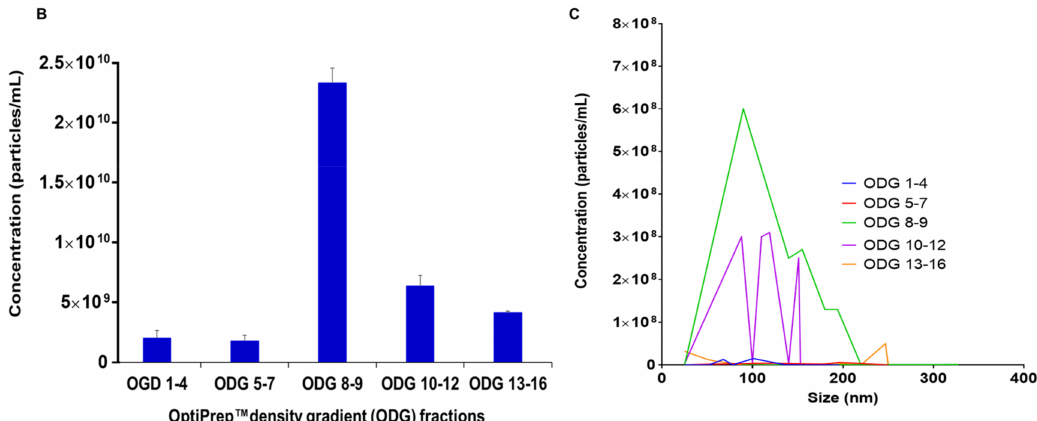
Figure 1. Characterization of EVs derived from concentrated conditioned medium (CCM) to demonstrate the abundance of EVs in the gradient fractions 8 and 9 after OptiPrepTM density gradient (ODG) ultracentrifugation. Pooled gradient fractions (ODG 1–4, 5–7, 8–9, 10–12, 13–16) were analyzed by ( A ) western blot for EV specific markers (CD63, TSG101) and non-EV specific markers (ApoA-I, Ago-2) to determine that the isolation process did not contaminate the EV-rich gradient fraction 8–9. Nanoparticle tracking analysis was applied to measure the ( B ) particle concentration and ( C ) the particle size in all pooled gradient fractions. Abbreviations: ODG 1–4 = OptiPrepTM density gradient fractions 1 to 4 (similar for 5–7, 8–9. 10–12, 13–16), FF derived EVs = follicular fluid derived EVs, M = marker (protein ladder).